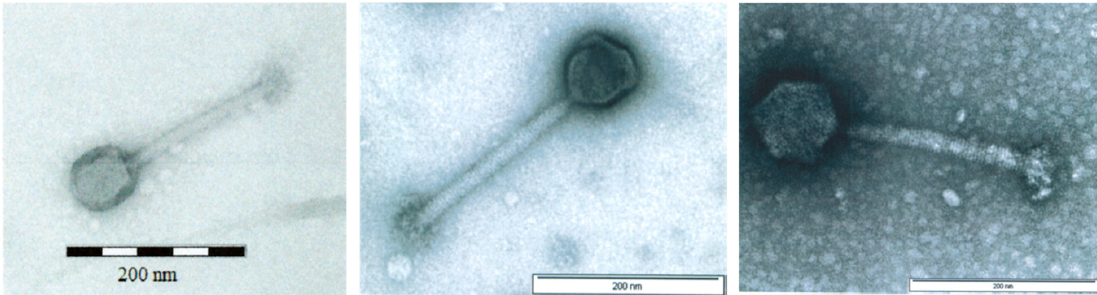
Figure 1. Transmission electron microscopy images of (left to right) Sa83, Sa87, and J-Sa36. Scale bars: 200 nm. Filtered lysates were PEG8000 precipitated, suspended in salt-magnesium buffer, stained with 2% uranyl acetate, and imaged at 80–100kV [39].